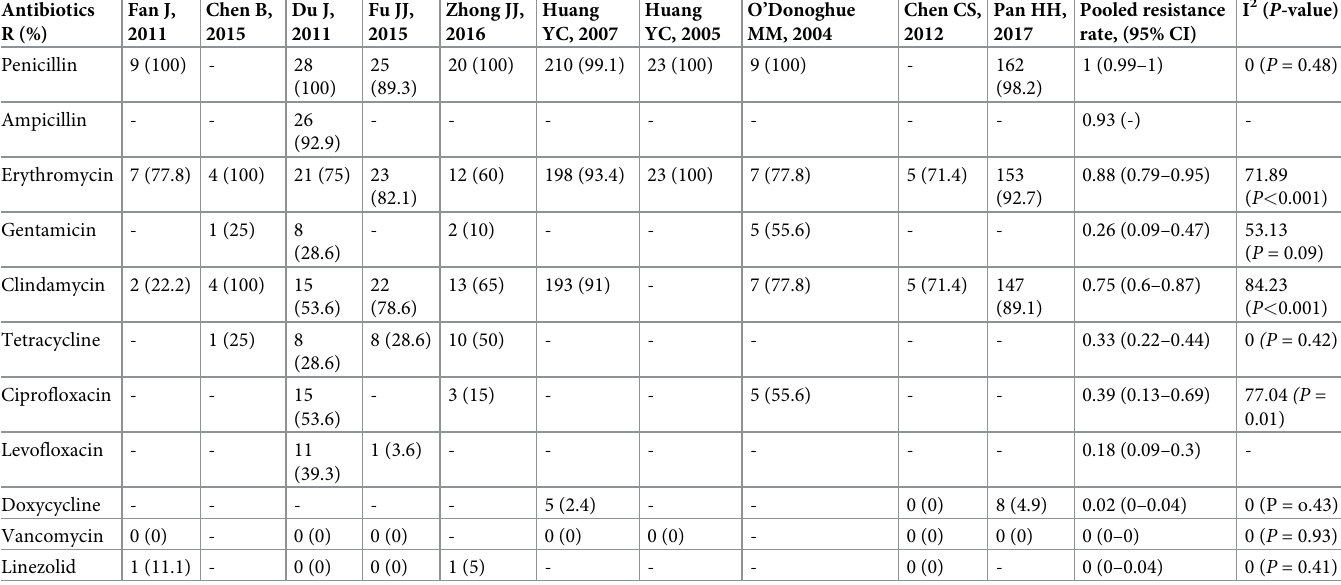
Table 5. Pooled prevalence of MRSA resistance to different antimicrobial agents in healthy Chinese